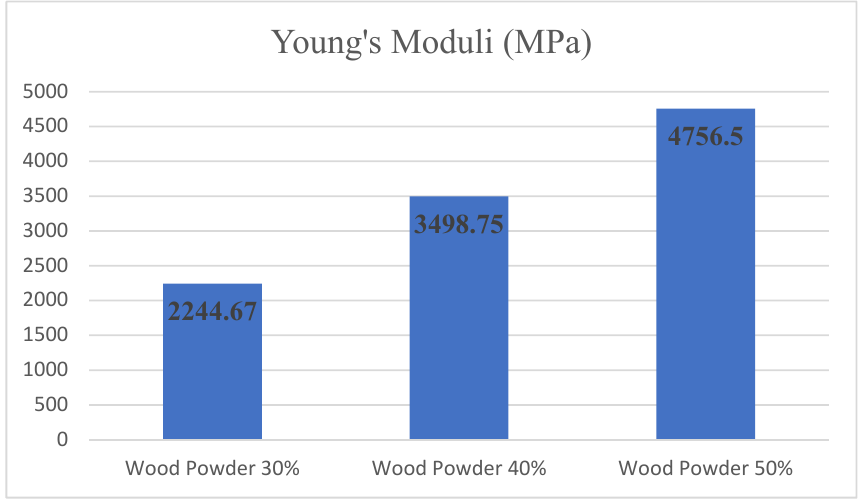
Figure 5. The Young’s moduli according to the amount of wood powder and 0% nanoclay addi- tion.